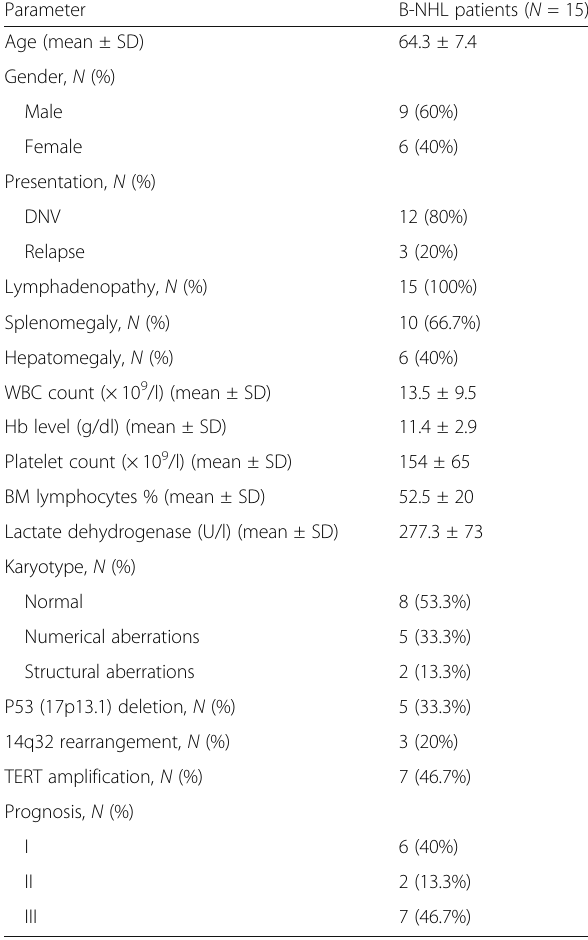
Table 3 Descriptive data of B-non-Hodgkin lymphoma patients (group